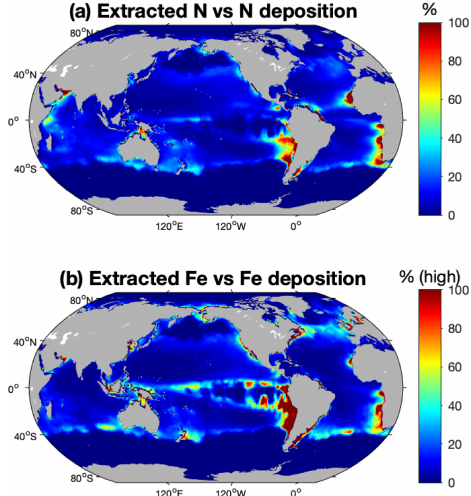
Figure 8. Ratio (%) between simulated extracted nutrients and cur- rent aeolian soluble nutrient inputs at the surface of the ocean for (a) N and (b) Fe. “low” and “high” refer to the use of 10 or 200µmolFe(molC) − 1 in fish,